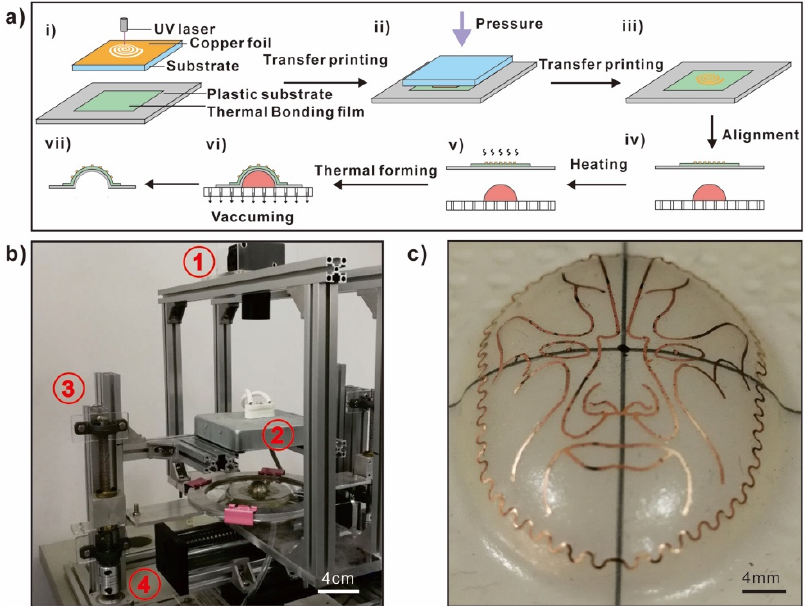
Figure 1. The manufacturing process of 3D conformable electronics: ( a ) The major steps of the thermoforming process: (i) Patterning the copper foil, (ii–iii) transfer printing, (iv) visual alignment—the three-dimensional model was put on the platform, and the sample was fixed by a special fixture, and (v–vii) thermoforming to the target surface through vacuuming. ( b ) A general view of the self-developed equipment. The system includes four core modules: ① The visual module, ② the heating module, ③ the loading module, and ④ the motion control module. With the help of visual recognition, the offset between the model and the sample is acquired, and then it is sent to the stepper motor, which drives the platform to move at a constant speed to achieve visual alignment. ( c ) Photo of a sample fabricated by this method.